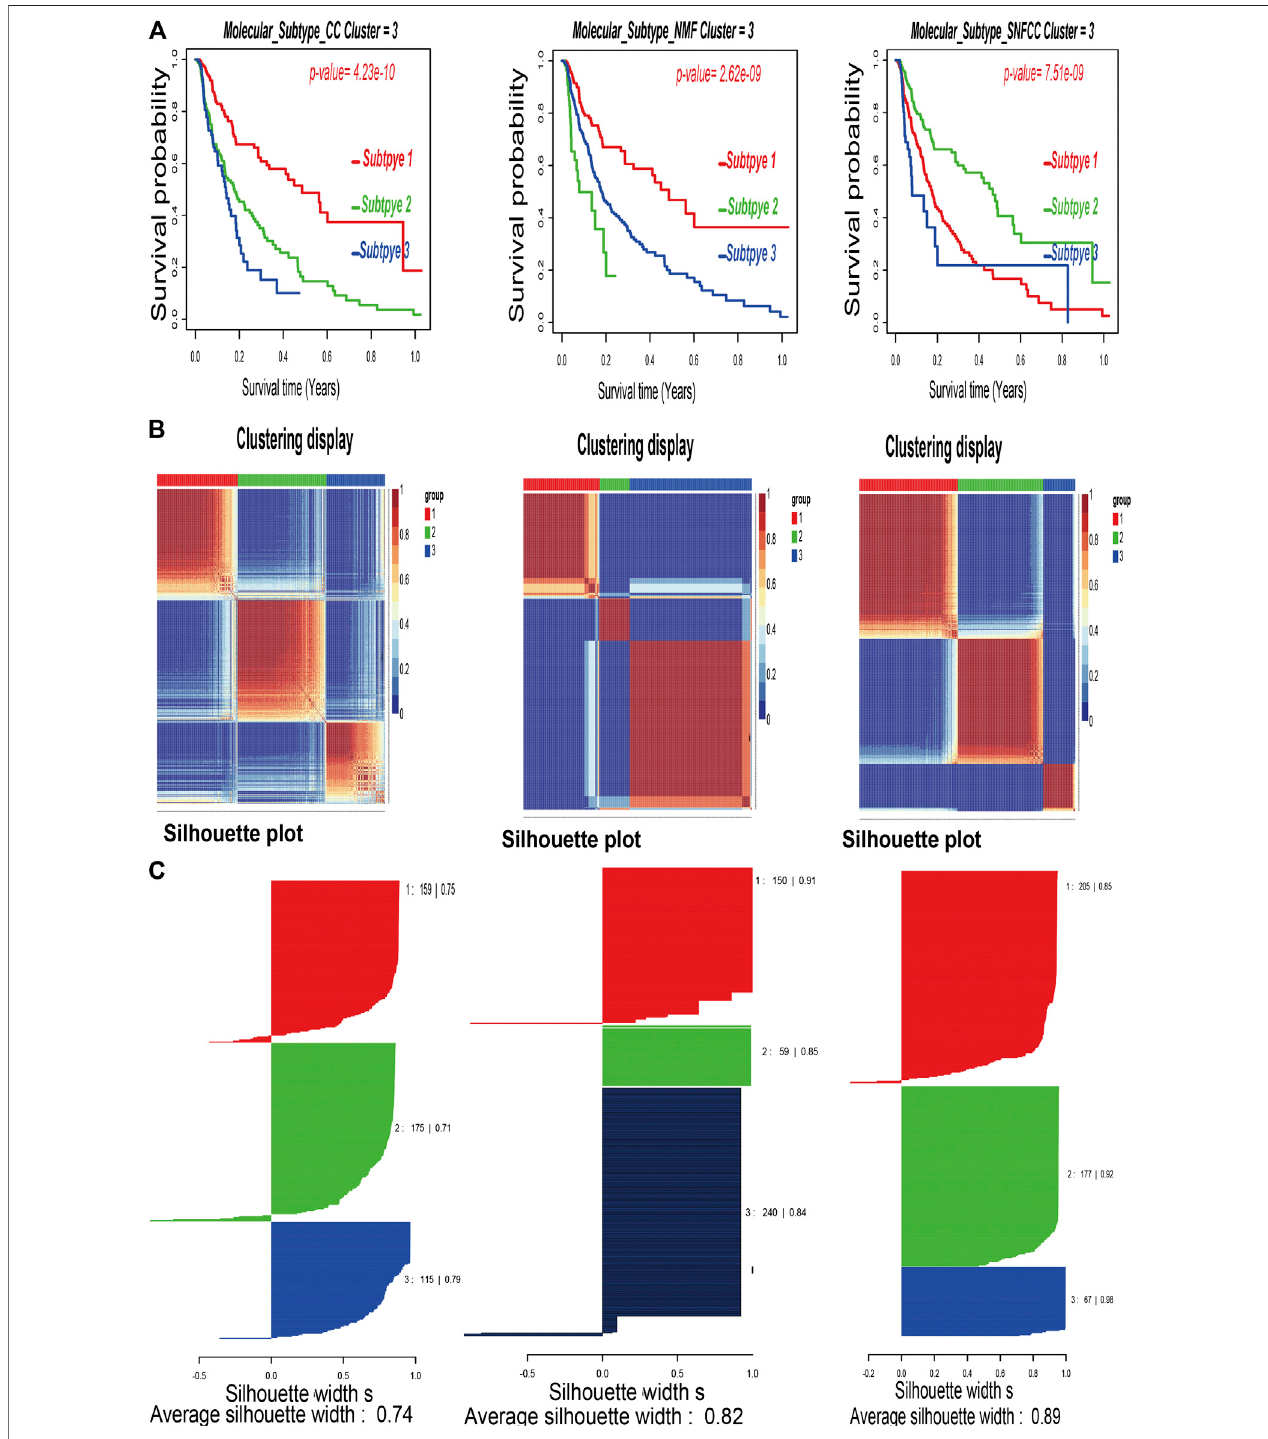
FIGURE 1 | Classi fi cation of melanoma patients by three clustering methods including consensus clustering (CC), consensus non-negative matrix factorization (CNMF),and similarity networkfusionwith CC (SNFCC). (A) : Kaplan – Meiersurvivalanalysis ofthree subtypes withlog-ranktest p value; (B) :clusteringheatmap ofthree subtype samples; (C) : average silhouette width representing the coherence of clusters.